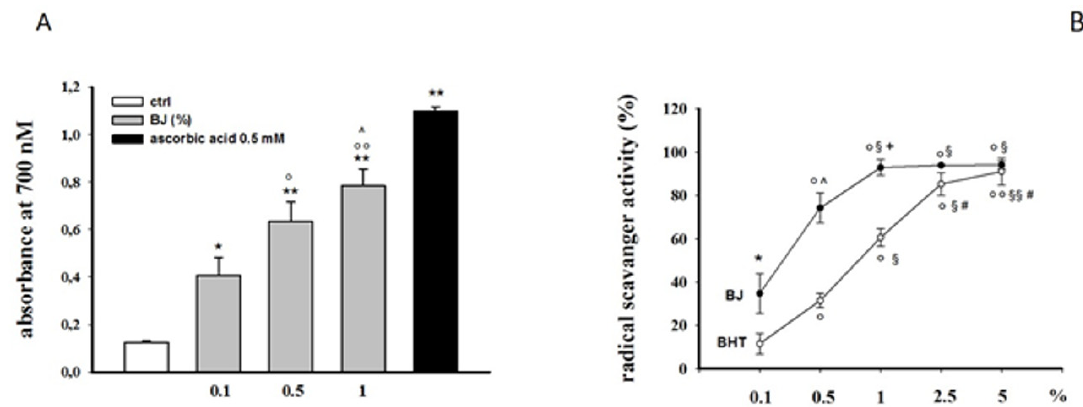
Figure 1. Antioxidant property of bergamot juice (BJ). Evaluation of reducing power ( A ) and DPPH scavenging activity ( B ) of BJ. The assays were carried out in triplicate and repeated three times. The results are expressed as mean value ± S.E.M. Different solutions of ascorbic acid (0.5 mM; A ) or dibutylhydroxytoluene (BHT) (0.1–5% w / v ; B ) were used as reference. * P < 0.05 and ** P < 0.01 vs. ctrl,